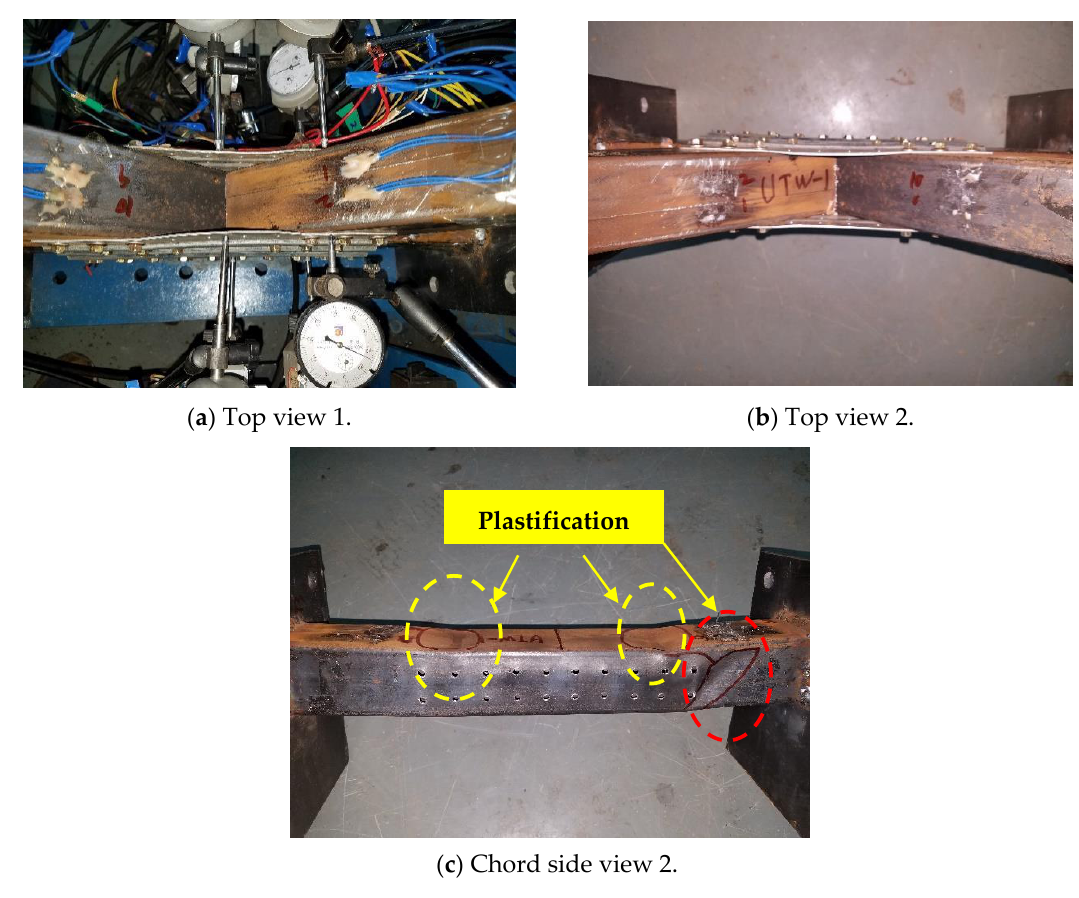
Figure 15. Deformation of specimen UTW-1.